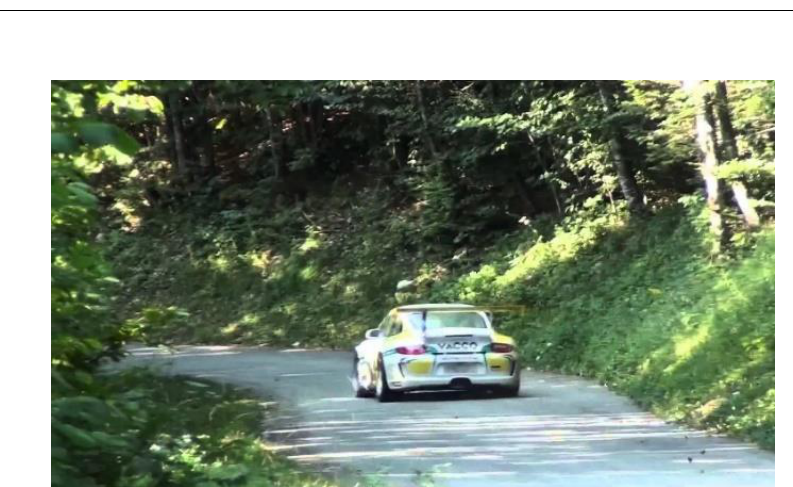
Figure 2. Sample image 2 and related API output. Figure 3. Sample image 3 and related API output.